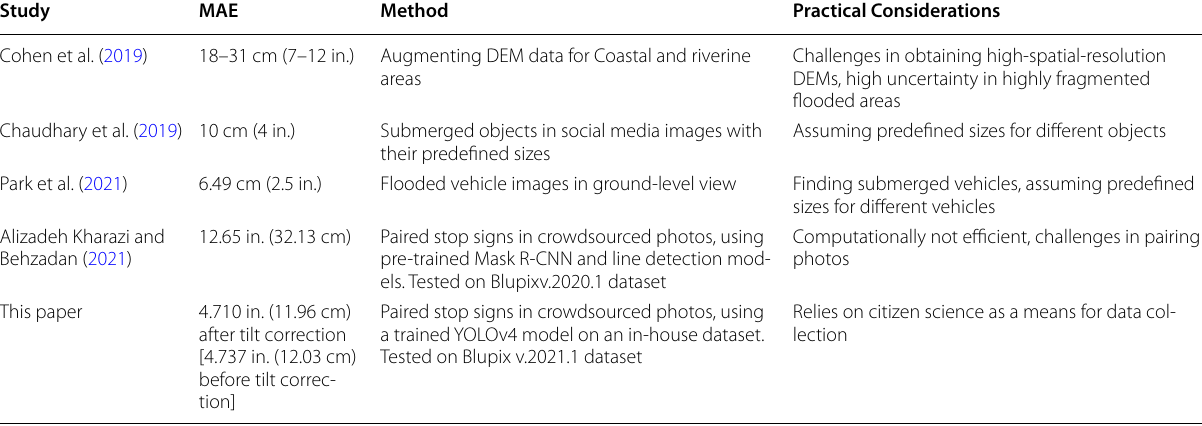
Table 7 Comparison of the results of this study with the literature on floodwater depth estimation